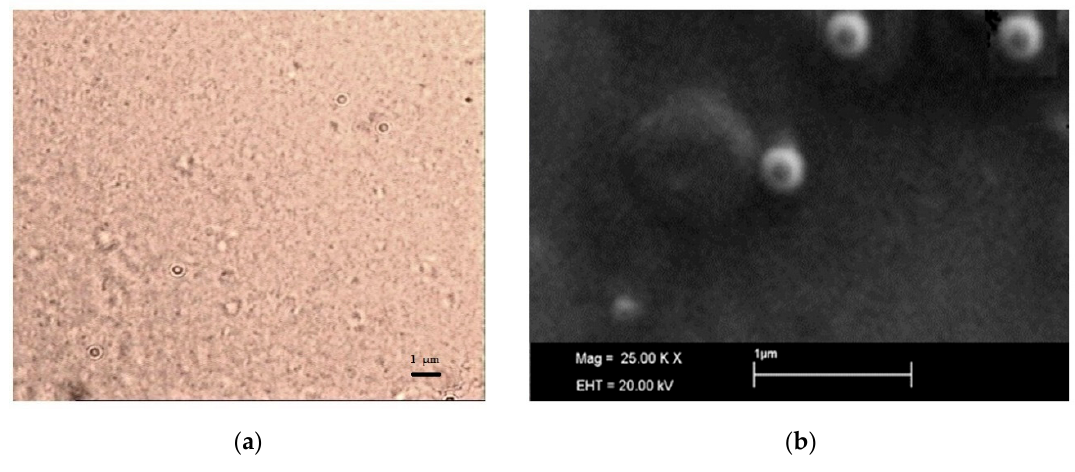
Figure 4. Images of dCEF-SLN: ( a ) optical microscopy (630×); ( b ) SEM (25,000×).